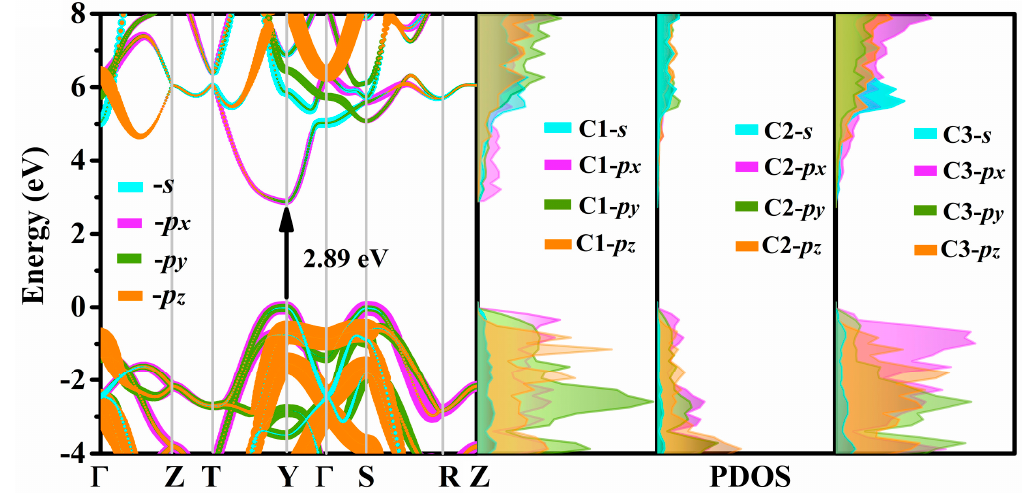
Figure 7. The calculated partial density of states (PDOS) and orbital projection band structure for Penta-C 20 . Cyan, magenta, olive, and orange lines correspond to the - s , - p x , - p y , and - p z orbitals of electrons.